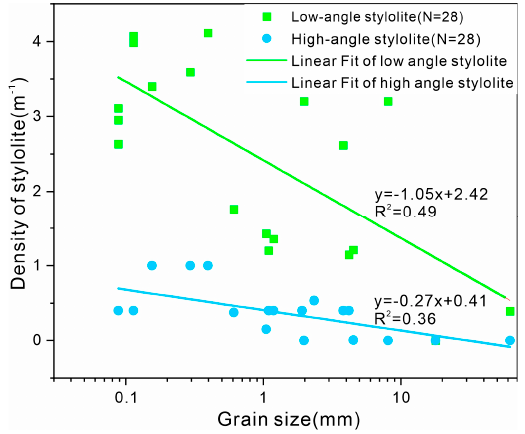
Figure 12. Relationship between grain size and density of stylolites.